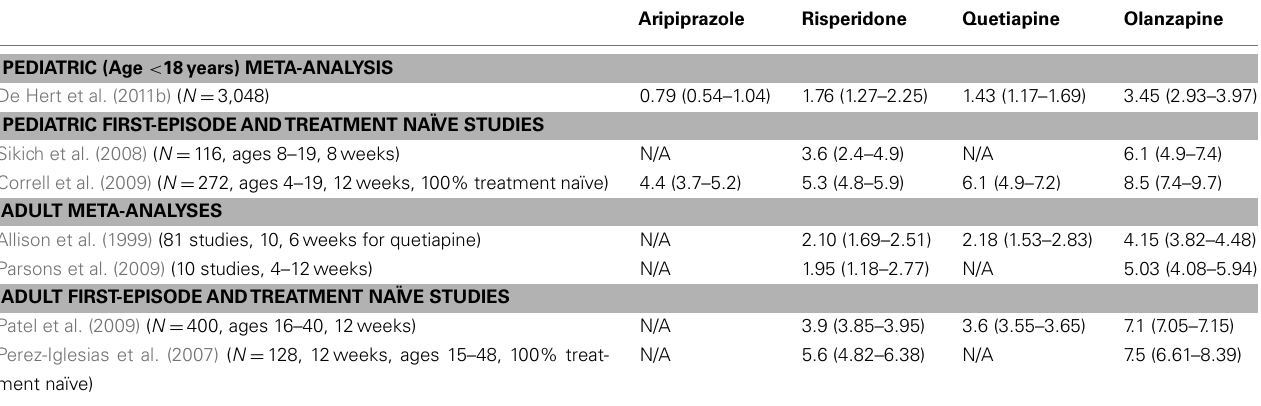
Table 1 | Mean (95% CI) antipsychotic-induced weight gain in pediatric and adult patients